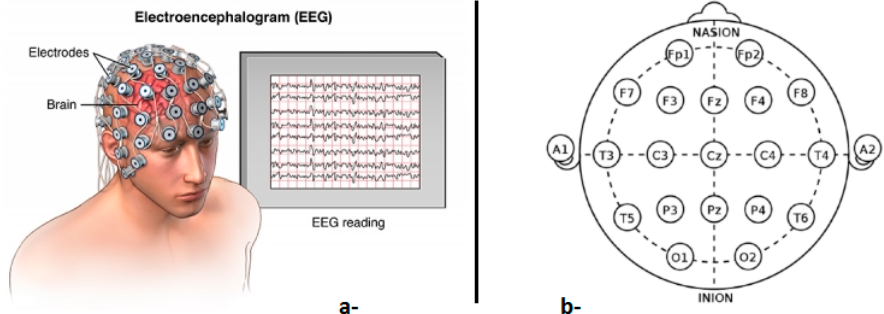
Figure 4. ( a ) Electroencephalogram (EEG) recording approach [102]; ( b ) placement of the electrodes